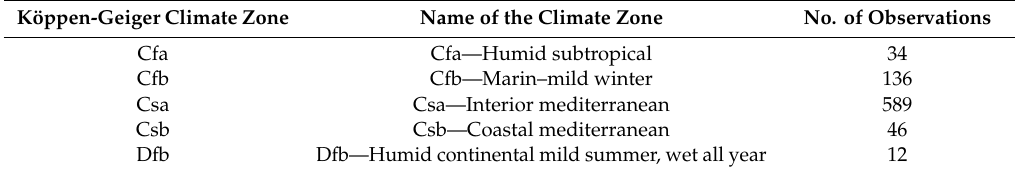
Table 3. Number of observations included in the meta-dataset per Köppen-Geiger climate zone Köppen-Geiger Climate